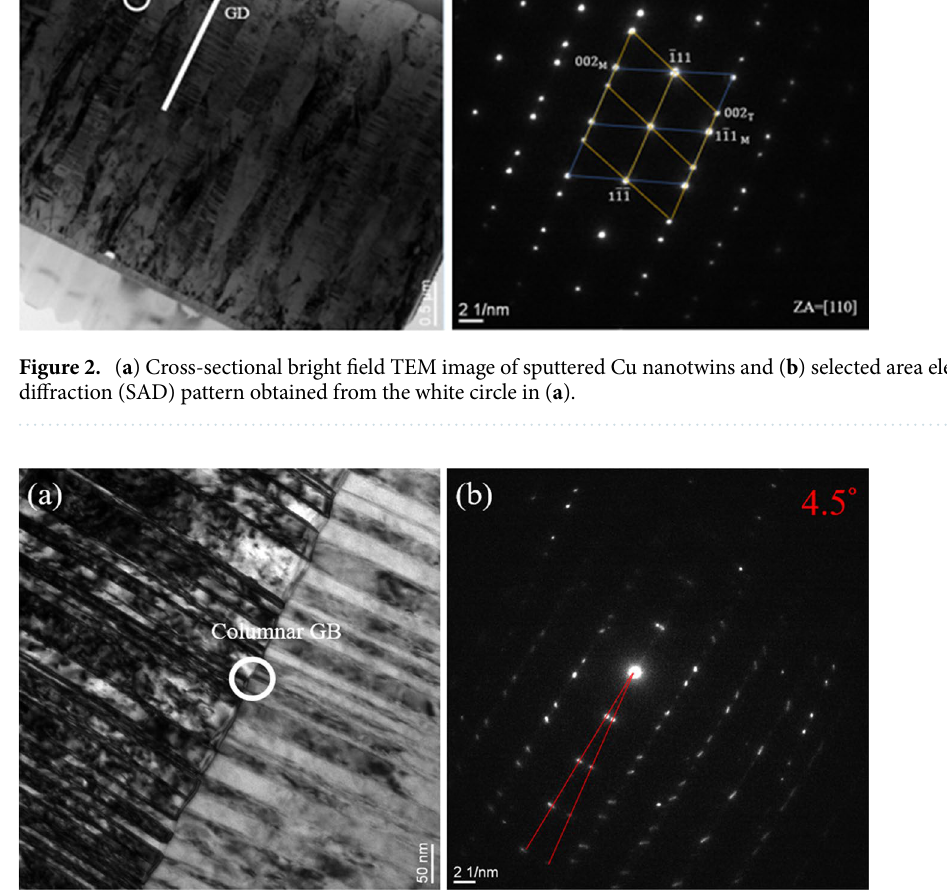
Figure 3. ( a ) Cross-sectional bright field TEM image of area between columnar grains. ( b ) Diffraction pattern obtained from the area in the white circle in ( a ) showing that the (111)-oriented planes across densely-packed nanotwinned columnar grains were misaligned by